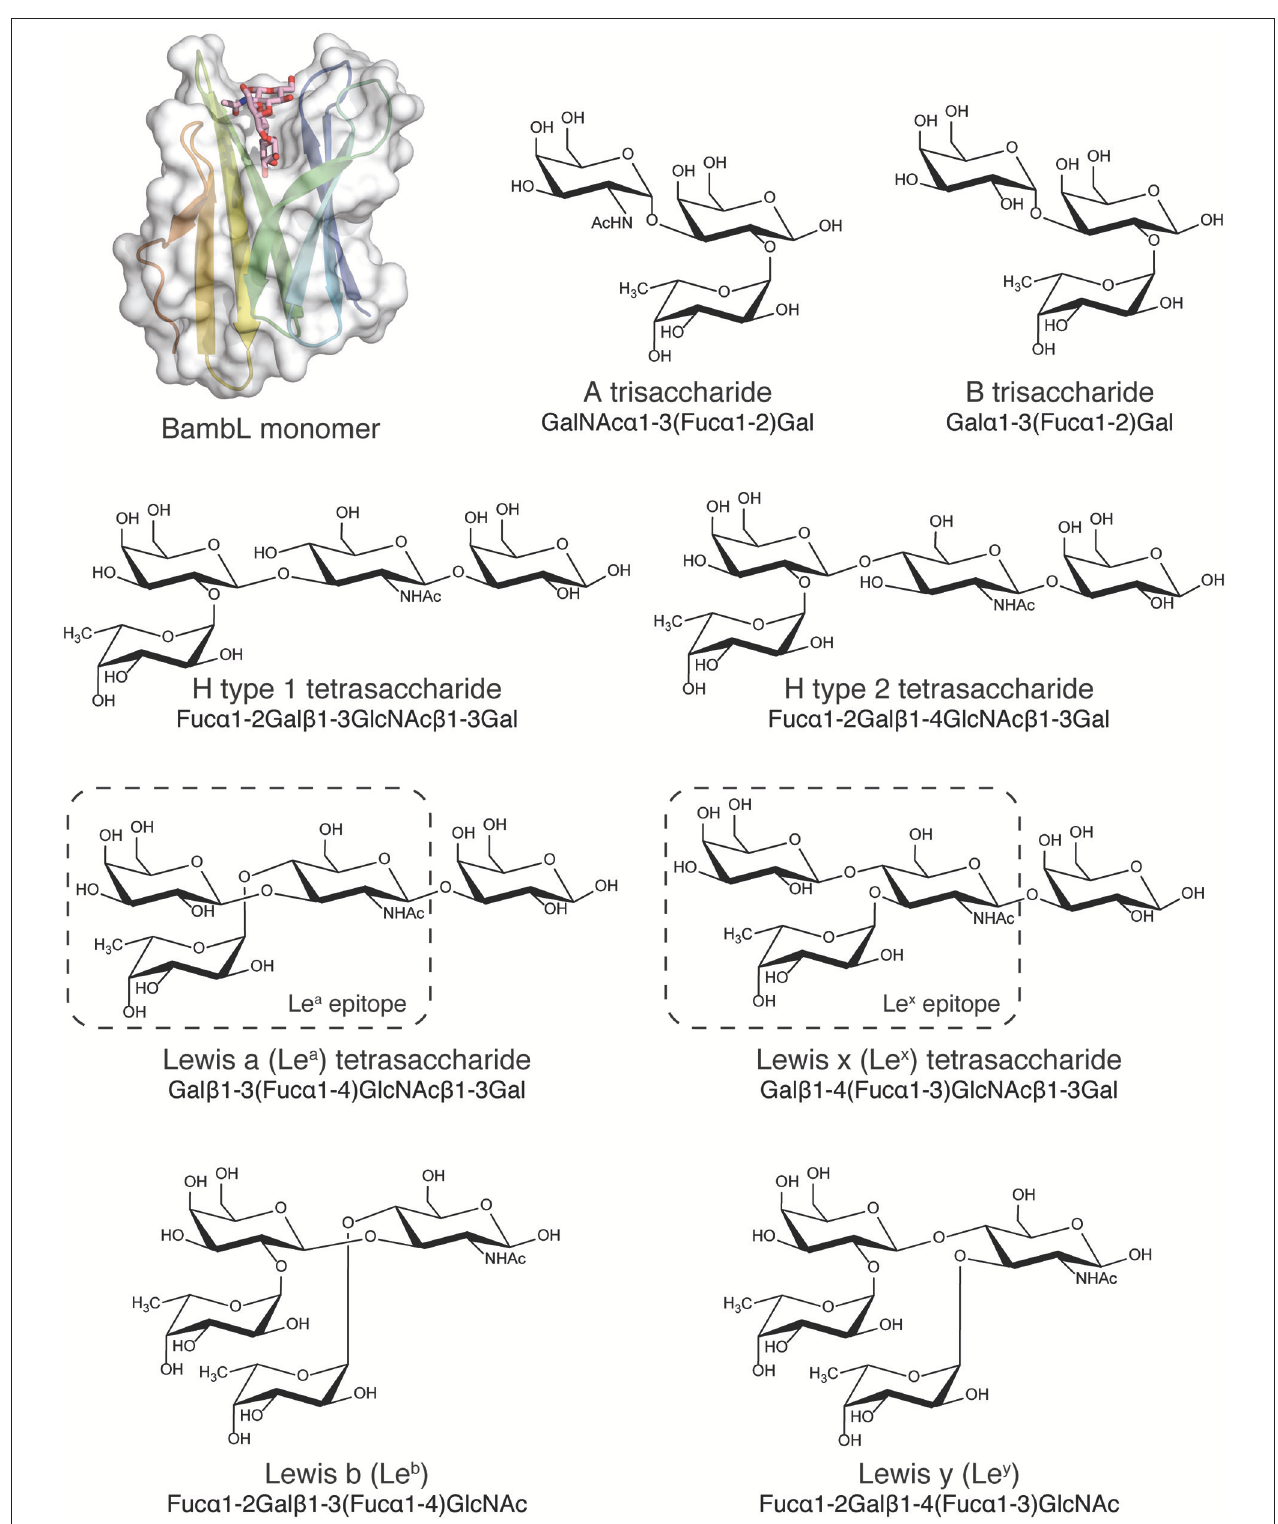
FIGURE 1 | BambL subunit shown with blood group and tissue antigen saccharides (A, B, H, Le a , Le b , Le x , and Le y ) used for simulation. BambL structure from PDB ID: 3ZZV, with the intra-protomeric binding site and ligand shown.